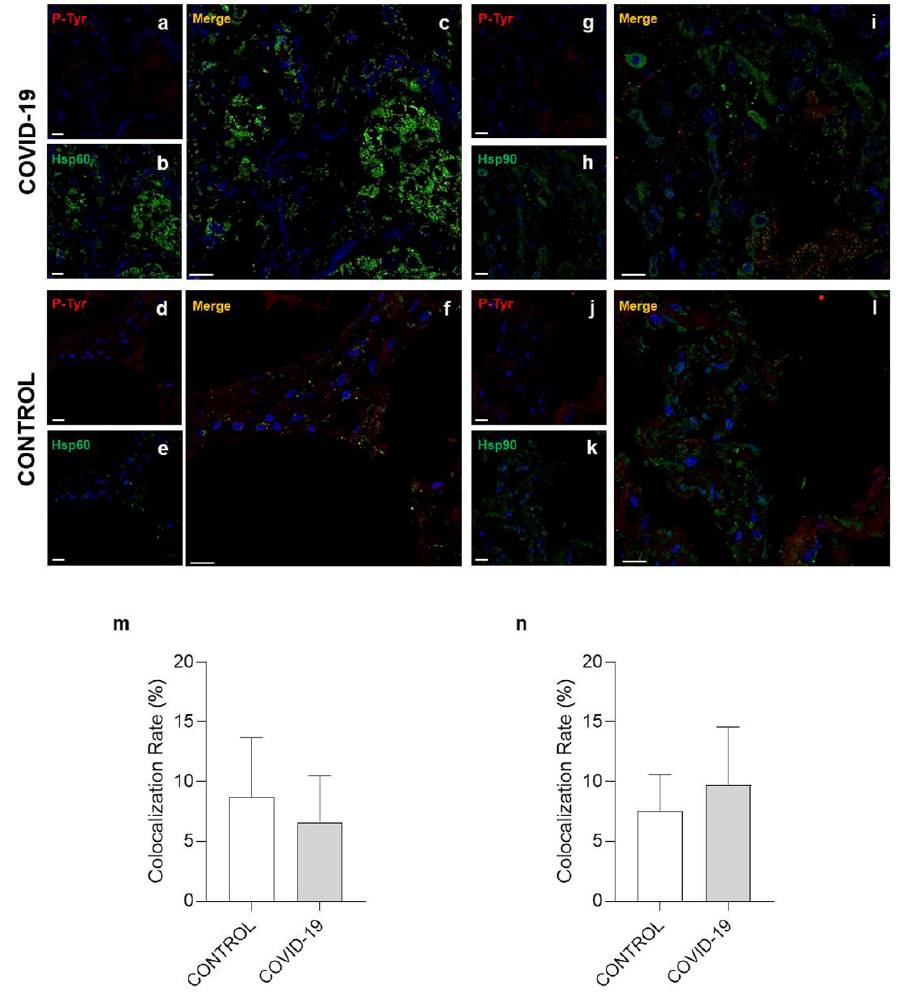
Figure 6. Immunofluorescence for phosphotyrosine, Hsp60, and Hsp90. ( a – c , g – i ) Representative images of COVID-19 lung parenchyma. ( a , b ) Representative immunofluorescence for phosphotyrosine (( a ), red) and Hsp60 (( b ), green); nuclei stained with DAPI are shown in blue. ( c ) The panel shows the merged confocal laser scanning image of phosphotyrosine, Hsp60, and nuclei. ( g , h ) Representative immunofluorescence for phosphotyrosine (( g ), red) and Hsp90 (( h ), green); nuclei stained with DAPI are shown in blue. ( i ) The panel shows the merged confocal laser scanning image of phosphotyrosine, Hsp90, and nuclei. ( d – f , j – l ) Representative images of control lung parenchyma. ( d , e ) Representative immunofluorescence for phosphotyrosine (( d ), red) and Hsp60 (( e ), green); nuclei stained with DAPI are shown in blue. ( f ) The panel shows the merged confocal laser scanning image of acetylate-lisine, Hsp60, and nuclei. ( j , k ) Representative immunofluorescence for phosphotyrosine (( j ), red) and Hsp90 (( k ), green); nuclei stained with DAPI are shown in blue. ( l ) The panel shows the merged confocal laser scanning image of phosphotyrosine, Hsp90, and nuclei. ( m , n ) The bar graph shows the colocalization ratio (%) for phosphotyrosine/Hsp60 ( m ) and phosphotyrosine/Hsp90 ( n ). Open bar, control; shaded bar, COVID-19. Data are presented as the means ± SD. Scale bar 25 µm.